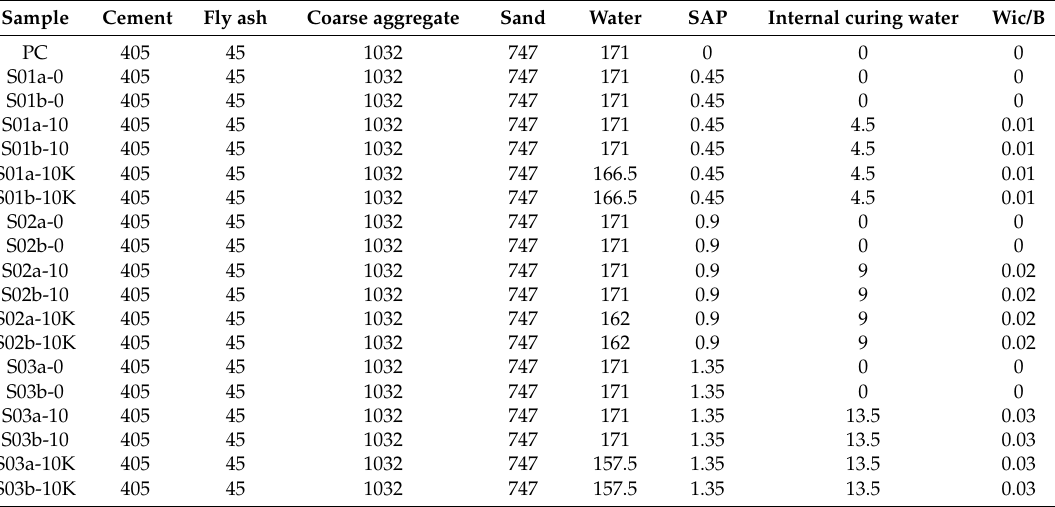
Table 4. Mix proportion of concrete (kg/m 3